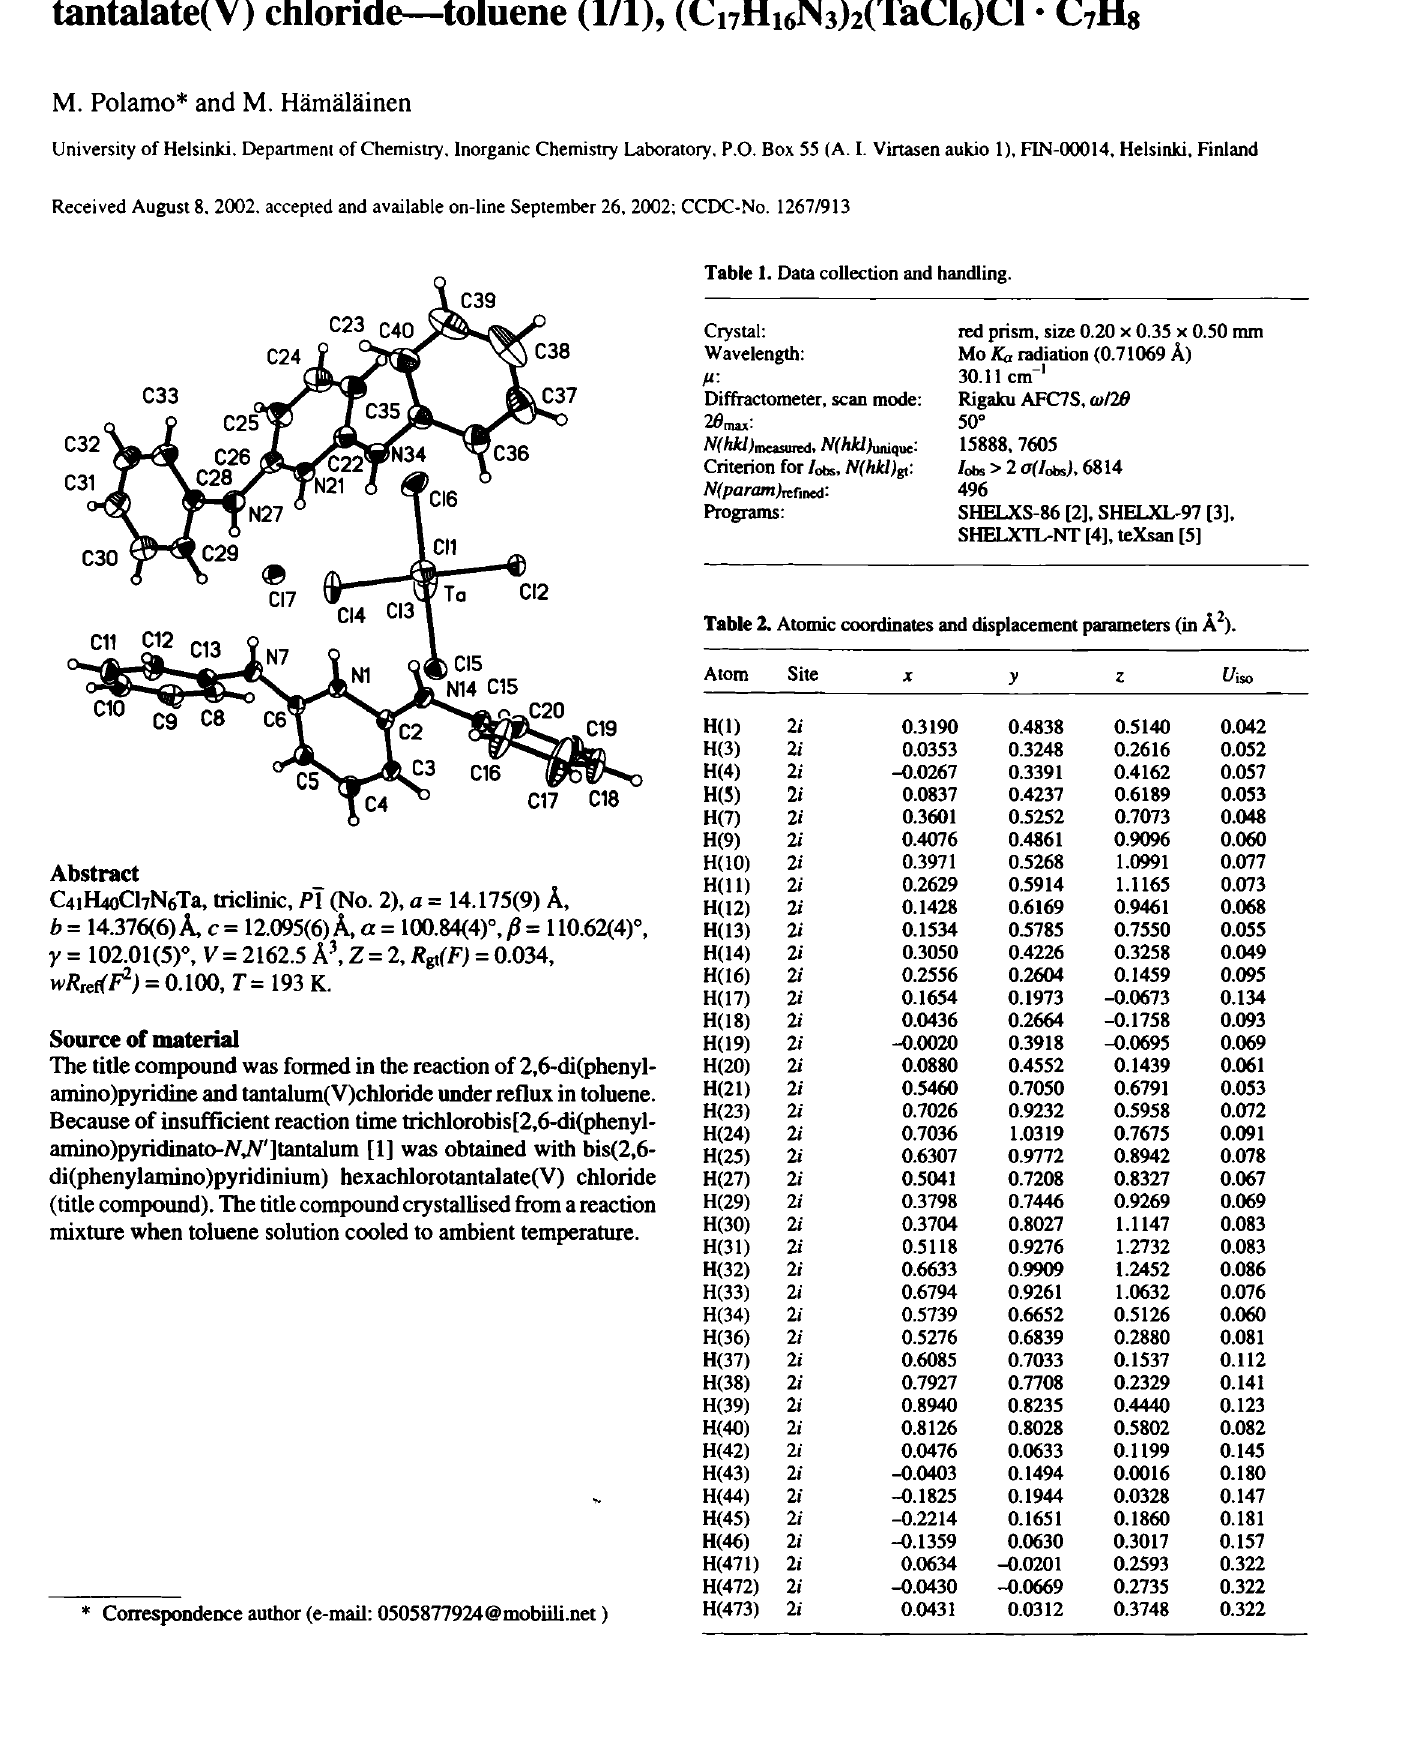
Table 1. Data collection and handling.